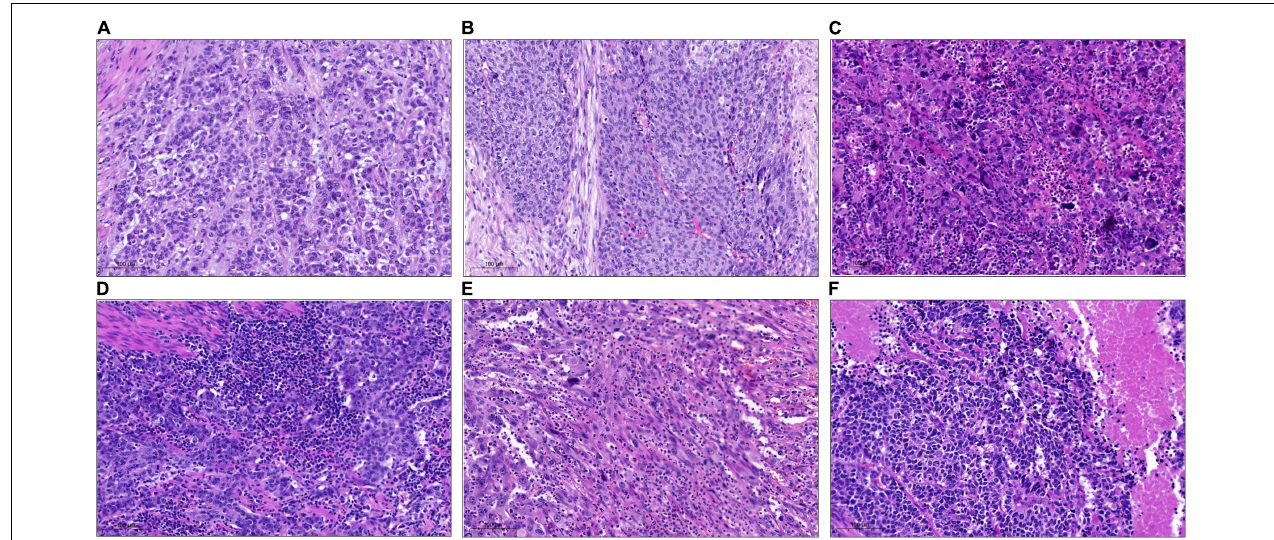
FIGURE 4 | Representative pictures of different histological subtypes on the whole slides classified as double negative in tissue micro array (TMA)-analysis and their molecular consensus subtypes. (A) Histological subtype: NOS; molecular Subtype: Stroma-rich. (B) Histological subtype: NOS (+ squamous on whole slide); molecular subtype: Ba/Sq. (C) Histological subtype: poorly differentiated/giant cell; molecular subtype: Ba/Sq. (D) Histological subtype: lymphoepithelial; molecular subtype: Ba/Sq. (E) Histological subtype: sarcomatoid; molecular subtype: Ba/Sq. (F) Histological subtype: neuroendocrine; molecular subtype: NE-like. Ba/Sq, basal/squamous; NE, neuroendocrine; NOS, not otherwise